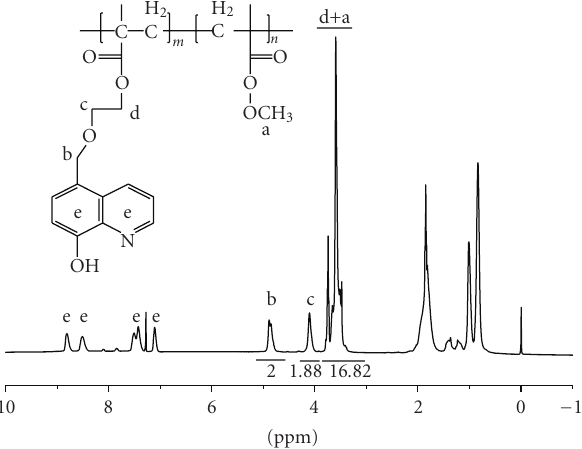
Figure 3: ln([ M ] 0 /[ M ]) and monomer conversion versus polymer- ization time. Kinetic plot of RAFT copolymerization of HQHEMA Figure 5: The 1 H NMR spectrum of random copolymer of and St. Polymerization conditions: [Monomer] 0 /[CPDN] 0 /[AIBN] 0 HQHEMA and MMA (poly(HQHEMA- co -MMA)) in CDCl 3 . = 1000 :10 :1, [Monomer] = [St] = 10: 1; T = 0 0 /[HQHEMA] 0 70 ◦ C.